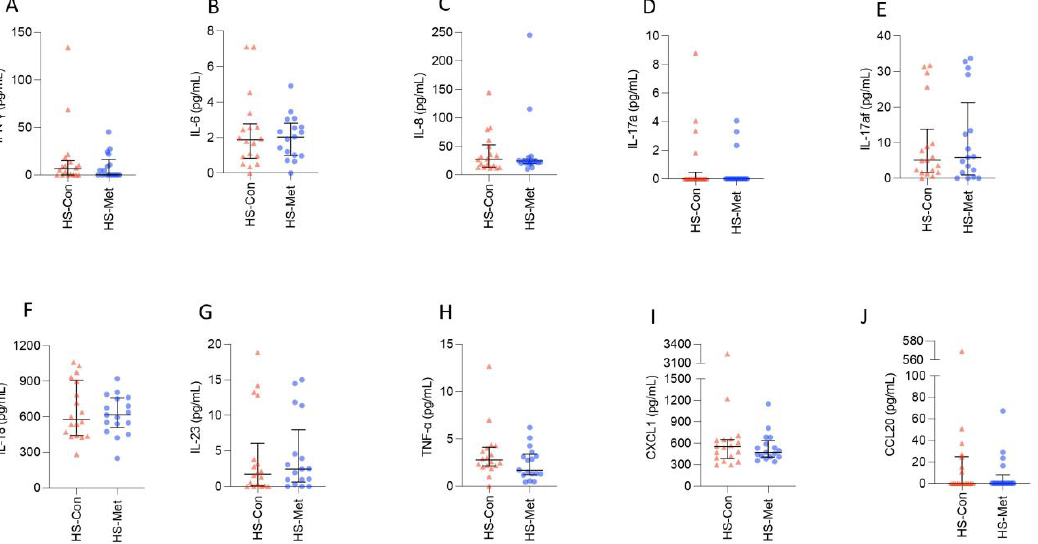
Figure 3. Trend towards a reduction in serum concentration of IFN- γ , IL-8, TNF- α , and CXCL1 in HS patients taking metformin compared with HS controls. Serum levels of cytokines and chemokines from control HS patients ( n = 18) and those taking metformin ( n = 17) were analysed using a multiplex assay: IFN- γ ( A ), IL-6 ( B ), IL-8 ( C ), IL-17a ( D ), IL-17af ( E ), IL-18 ( F ), IL-23 ( G ), TNF- α ( H ), CXCL1 ( I ), and CCL20 ( J ). Graphs represent individual samples with median and IQR. Statistical significance was calculated using the Mann–Whitney test. IQR = interquartile Table 5. Trend towards a reduction in serum concentration of IFN-γ, IL-8, TNF-α, and CXCL1 in HS patients taking metformin compared with HS controls.